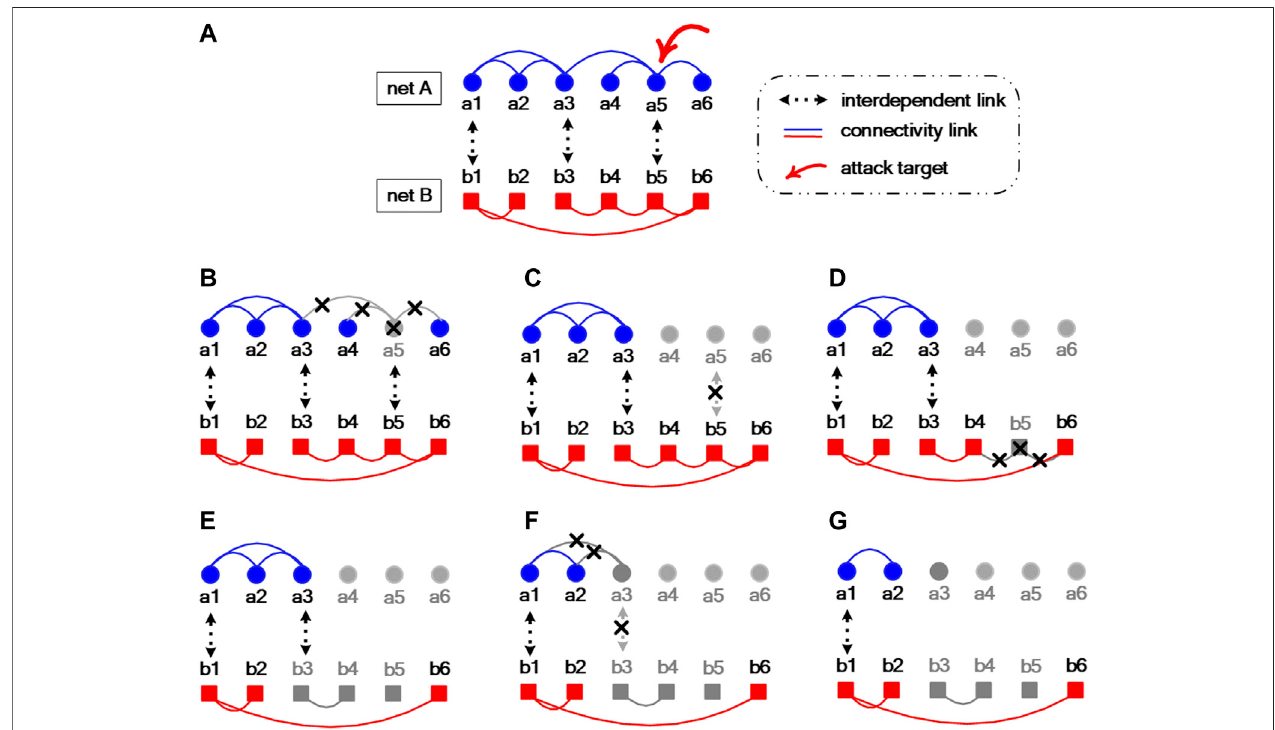
FIGURE1| (Coloronline)Schematicillustration ofapartiallyinterdependentsystemwithtwonetworks( A and B )andthecascade processofsuccessive failuresof nodesandlinksofbothnetworksinducedbysinglenoderemoval( a 5 )duetotheexistenceofinterdependence. (A) Apartiallyinterdependentsystemwithnetwork A and (cid:1)(cid:1)(cid:1)(cid:1) B . Nodes { a i | 1 ≤ i ≤ 6 } in network A and nodes { b j 1 ≤ j ≤ 6 } in B are represented by solid circles and squares, respectively. The connectivity links, such as link ( a 1 - a 2 ) and link ( b 1 - b 5 ), are represented by solid lines. The dependency links, such as link ( a 5 - b 5 ), are represented by dashed lines. (B – F) Schematic illustration of the back- and-forth propagating process of cascading failures of nodes and links between two networks after node a 5 (one of nodes with highest degree in network A ) is selected and attacked externally. The failure of node a 5 induces the damage on connectivity integrity of network A . Furthermore, due to the interdependence between networks, the removal of nodes and links in network A triggers the failures of nodes and links in network B . This propagating process between networks stops only until no further node and link are eliminated. (G) Finally stabilized system, network A is with largest connected component { a 1 , a 2 } and B is with { b 1 , b 2 , b 6 } ,